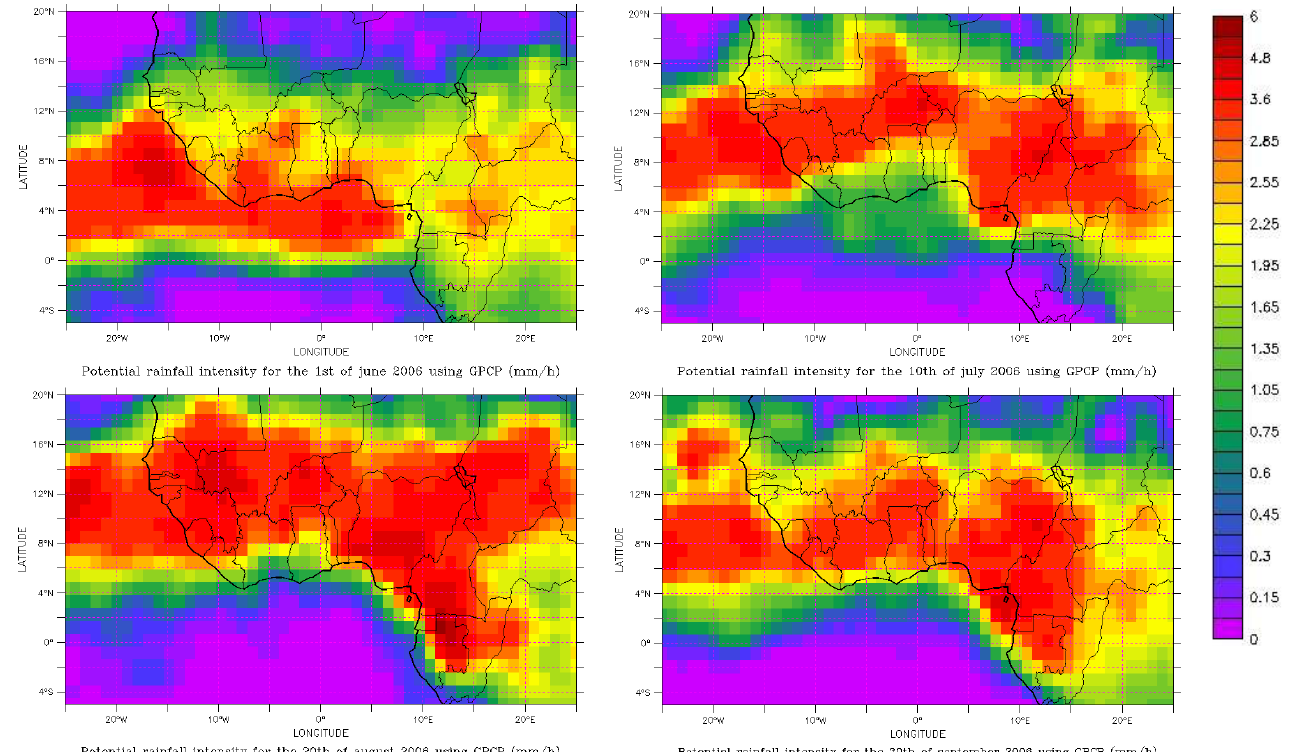
Fig. 9. Rainfall potential intensity maps computed without spatial integration window.